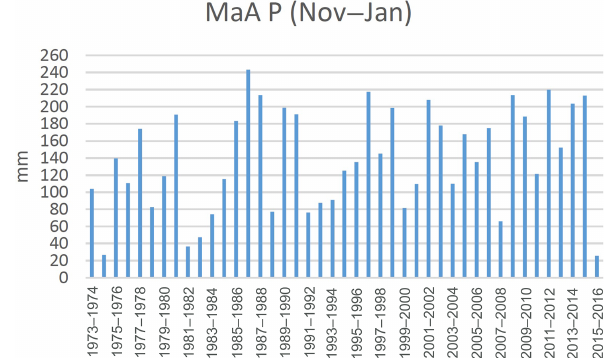
Figure 9. Accumulated precipitation from November to January at the Mallorca airport.